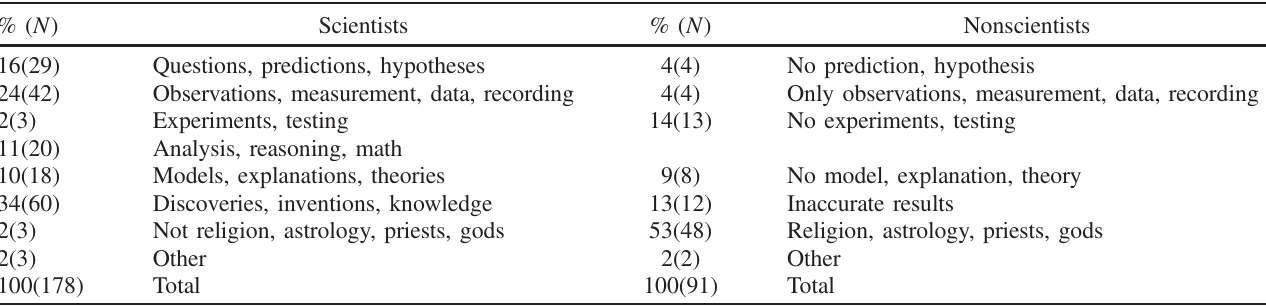
TABLE I. Evidence students used to argue that ancient people were or were not scientists — overall.